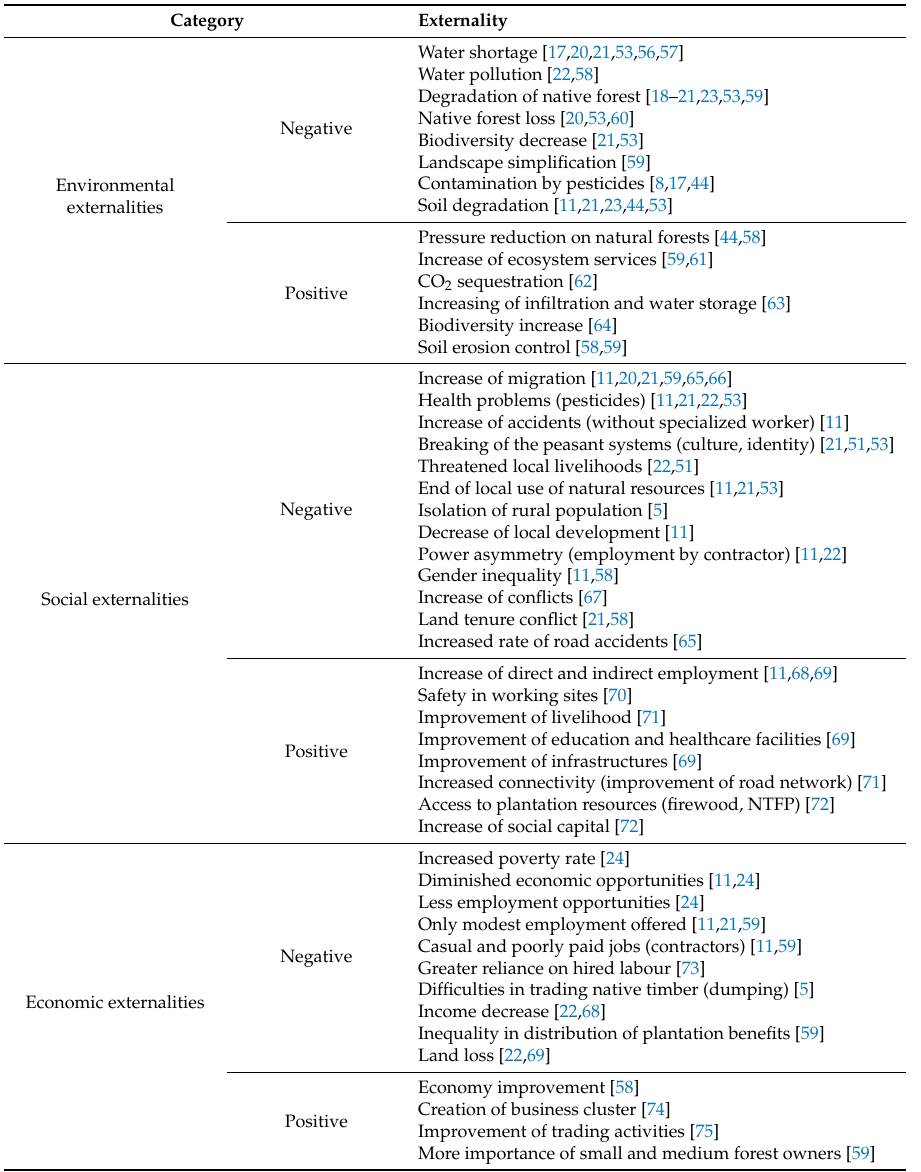
Table A1. Externalities found in the literature